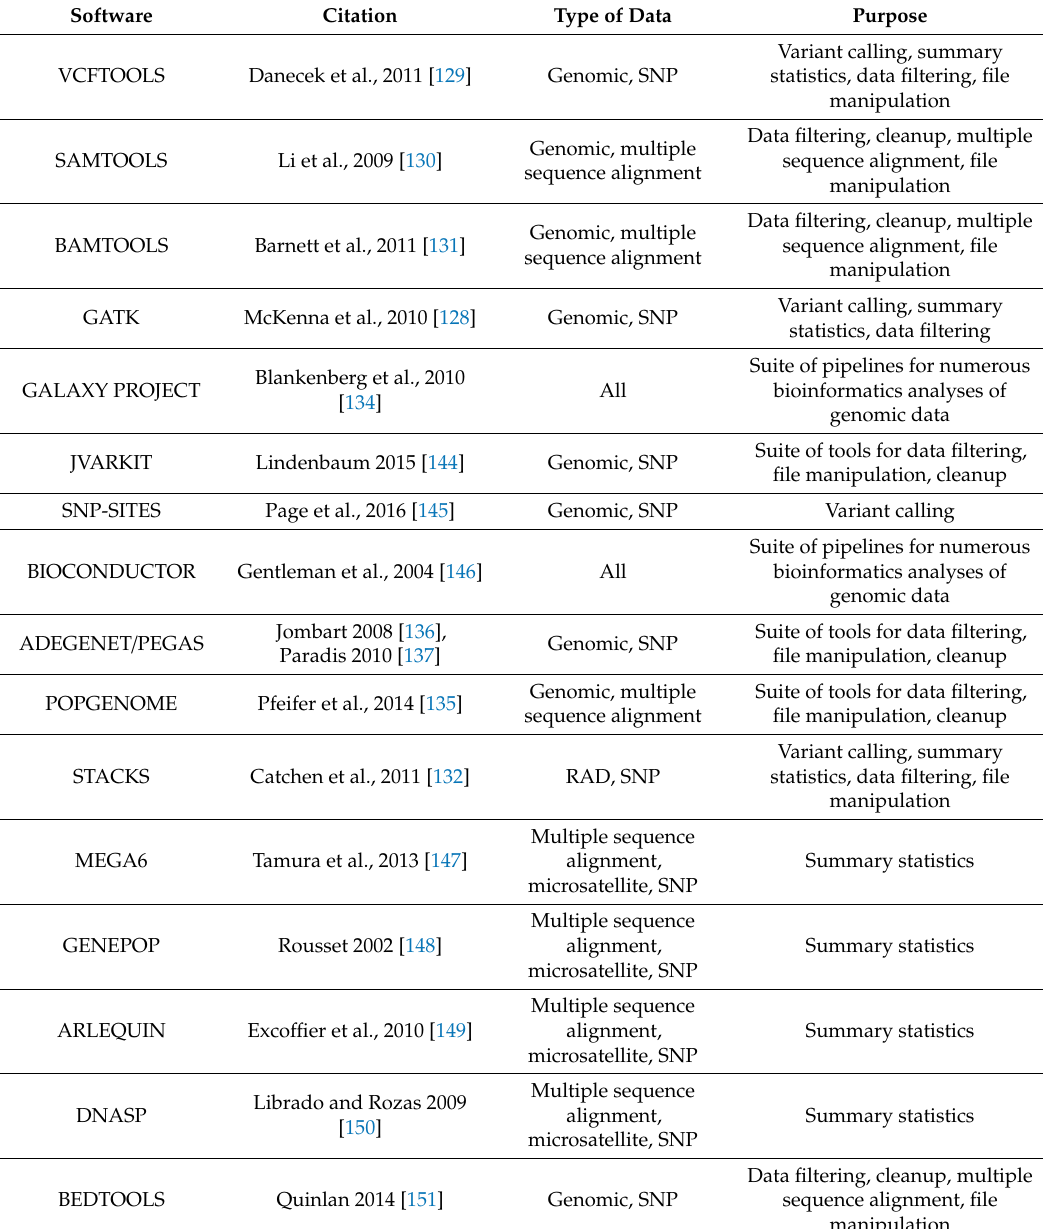
Table 3. List of commonly used tools / pipelines for preliminary analyses (data compilation, assembly, filtering, quality control, formatting) of population genomic